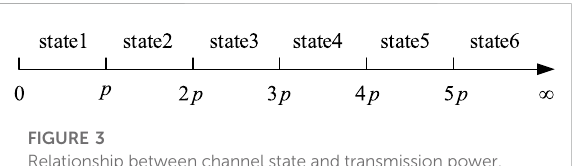
FIGURE 3 Relationship between channel state and transmission